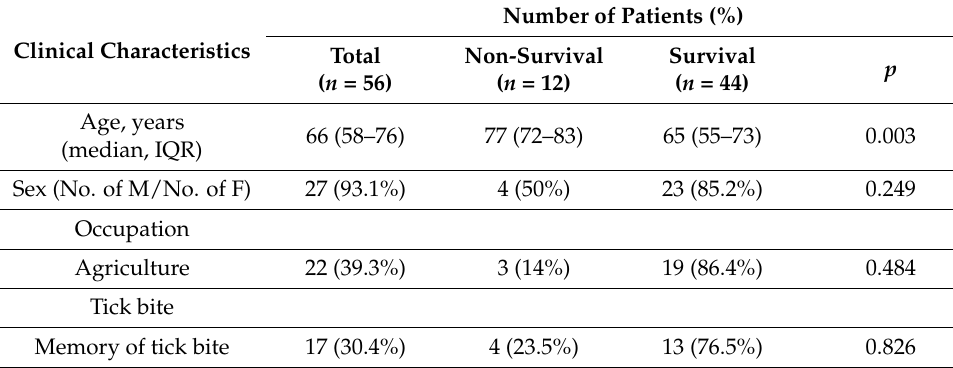
Table 1. Clinical characteristics of patients with SFTS ( n = 56).